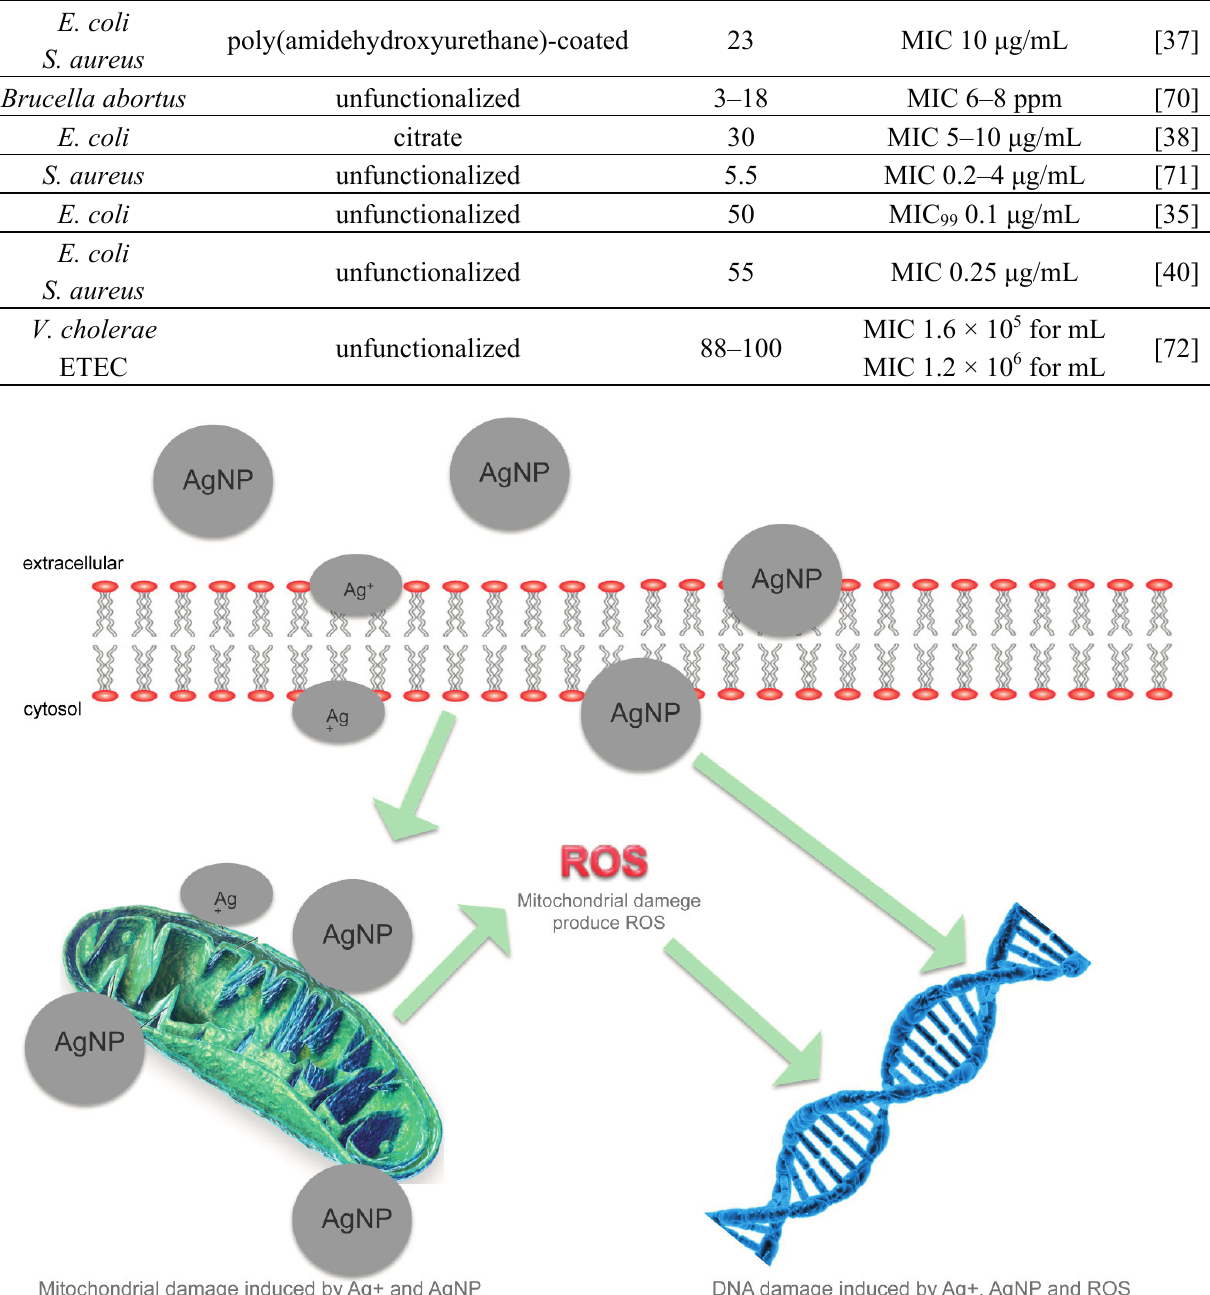
Figure 2. Schematic representation of various cellular responses to AgNP-induced toxicity mechanisms. In particular AgNPs induce mitochondrial and DNA damage by